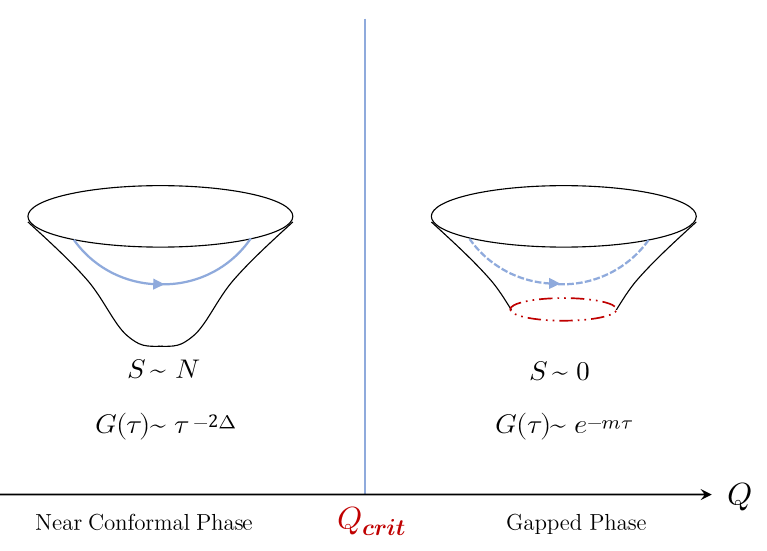
Figure 1 . A depiction of the transition of N = 2 SYK, along with a schematic dual bulk geometries in each phase. At background charge Q = 0 , it was shown in [6] that the model possesses a superconformal solution. We show that for Q < Q supersymmetry may be lost (depending on crit which model is under consideration), but a conformal solution exists. This system is dual to a (possibly supersymmetric) AdS geometry with a Euclidean horizon and a large extremal 2